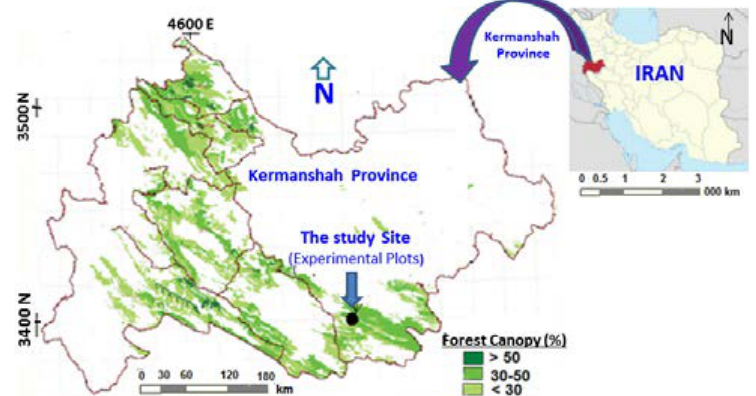
Fig. 1: Location of the study area